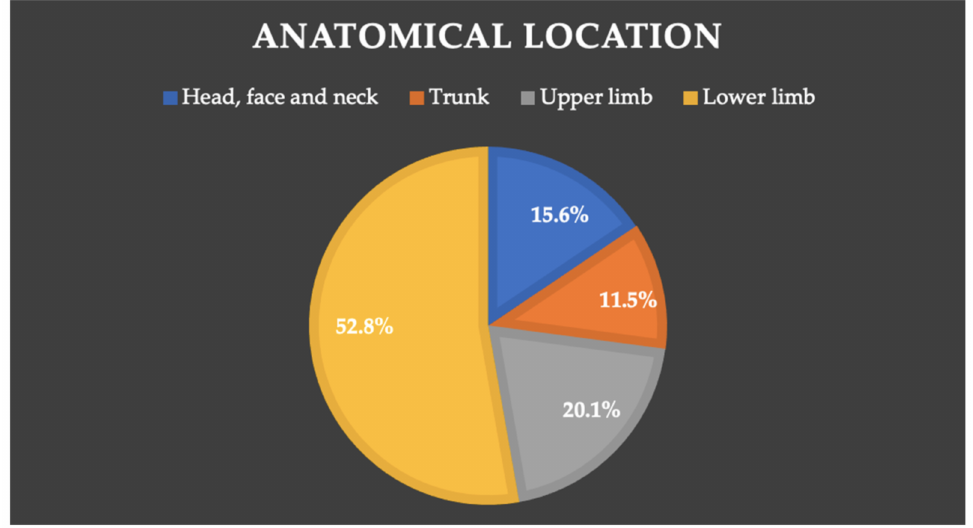
Figure 1. Anatomical location.